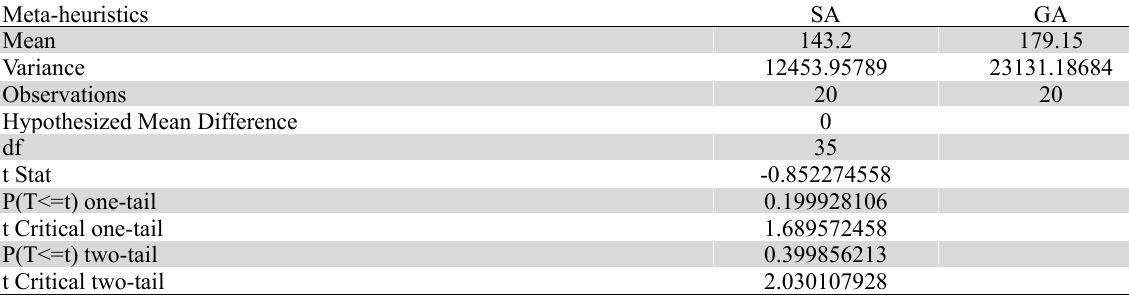
Result of the t -test for SA and GA computational